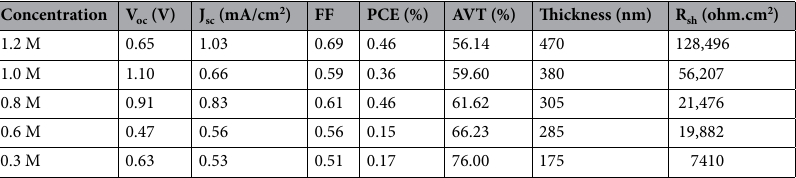
Table 1. AVT and average PV performances for different concentrations and thicknesses at 1.5% Cs under one sun.